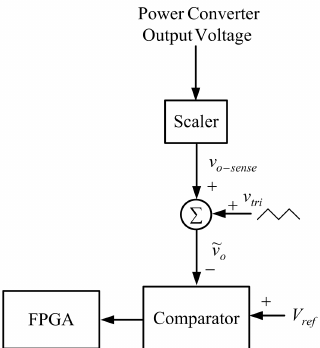
Figure 14. Comparator sampling with the triangular wave injection method.